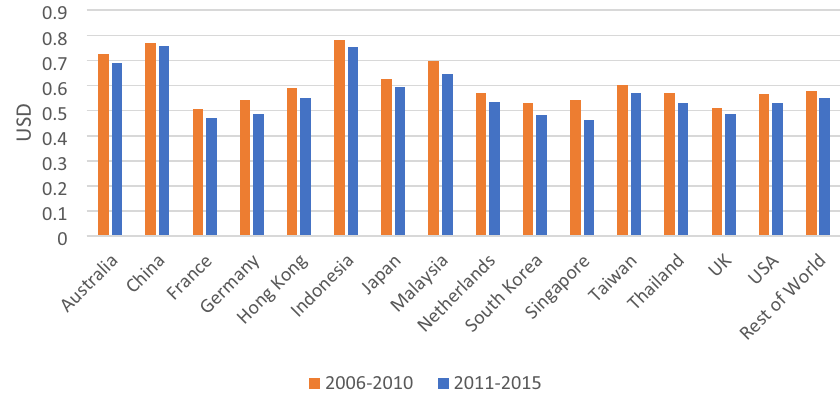
Fig. 6 Value-added intensity of Vietnam’s exports by